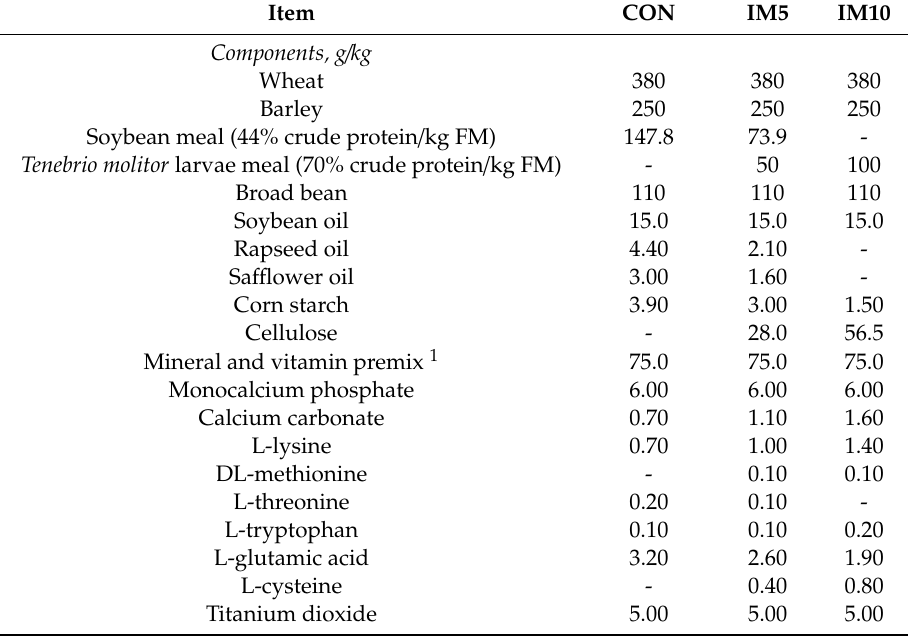
Table 1. Composition, nutrient, and energy contents of the experimental diets.